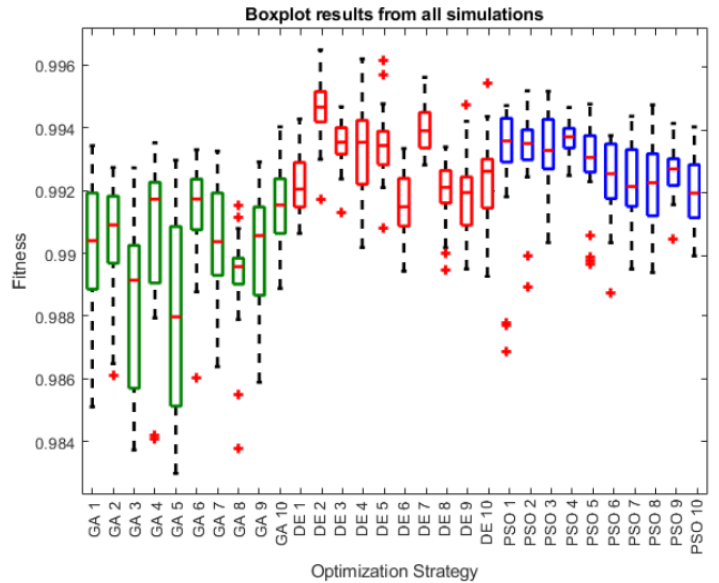
Figure 7. Boxplot graphic for the fitness considering each the 10 variations of control’s strategy—GA (green), DE (red) and PSO (blue)—described in Section 4. The median is indicated by the horizontal line that runs in red at the center of the box. The two vertical dashed lines in black, called whiskers, extend from the bottom and top of the box to report the smallest and largest non-outlier in the data set, respectively, while the outliers are plotted separately as a cross on the chart.